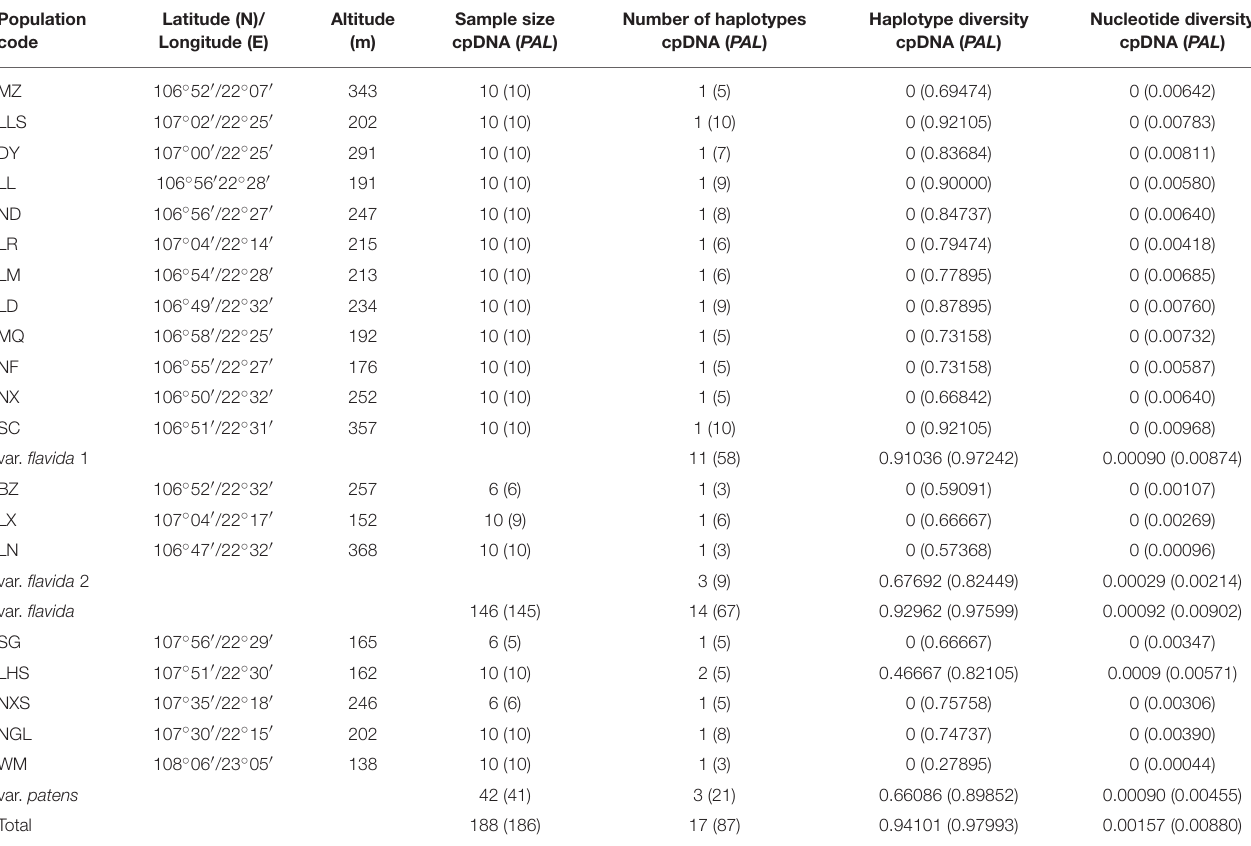
TABLE 2 | Geographical location, sample size, and genetic diversity of C. flavida based on cpDNA and PAL sequences. Population